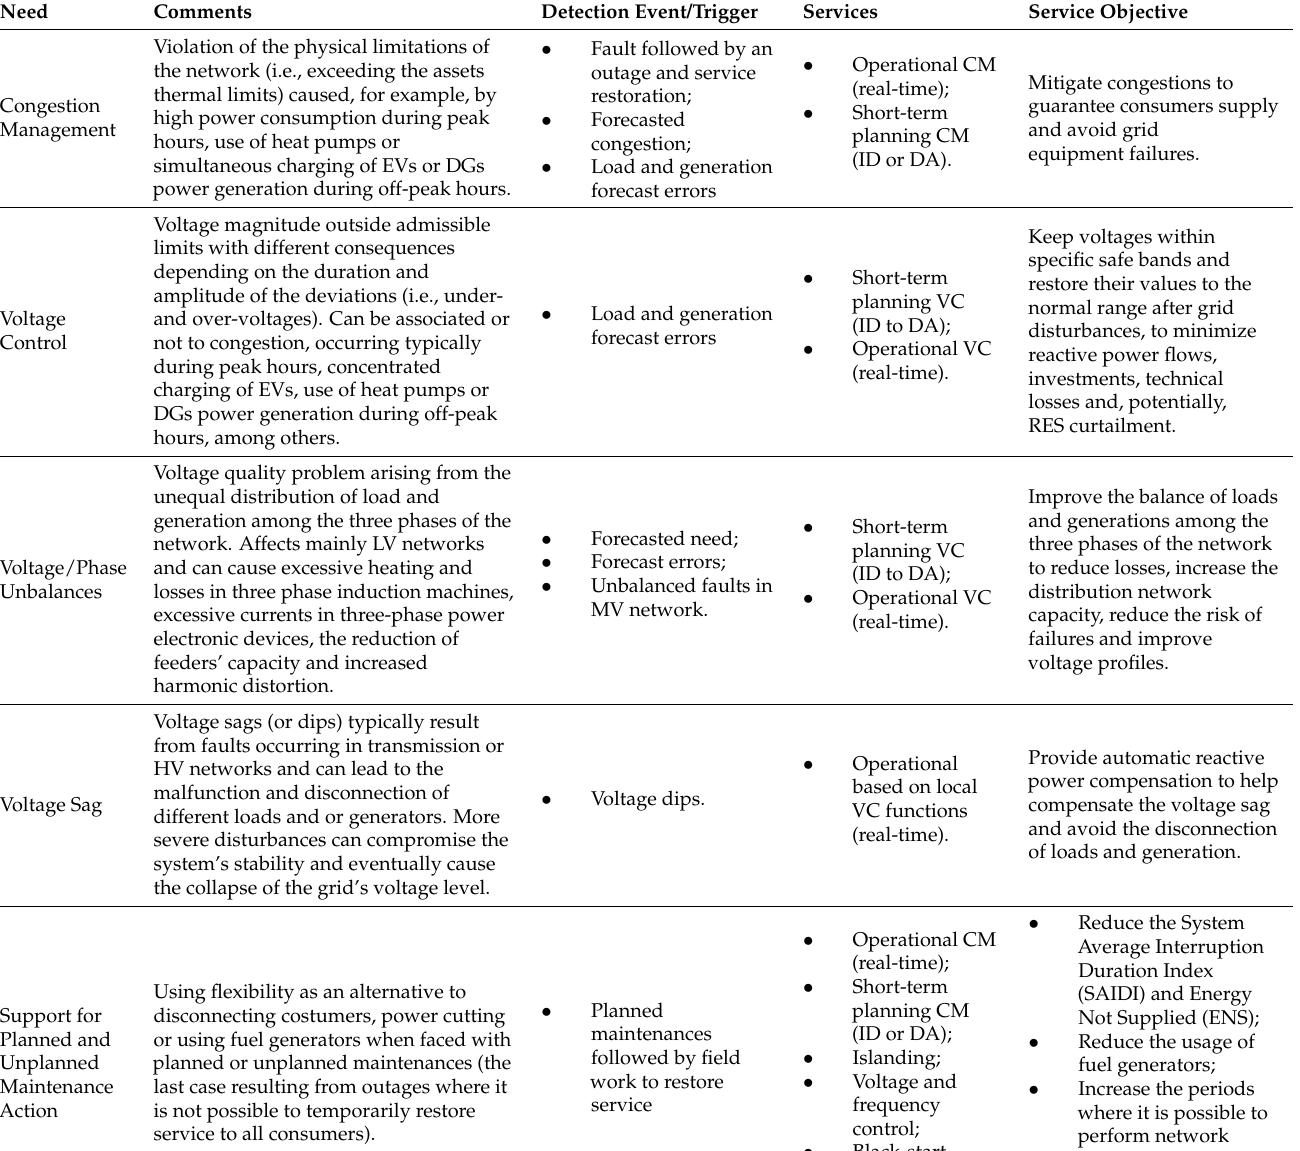
Table 4. DSO needs and future flexibility